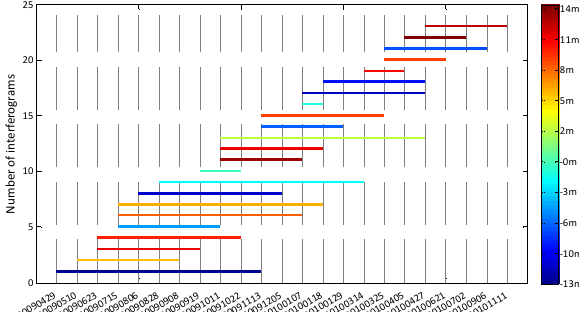
Figure 3. The spatial and temporal baselines of the 23 USB interferometric pairs used for TCP solution.